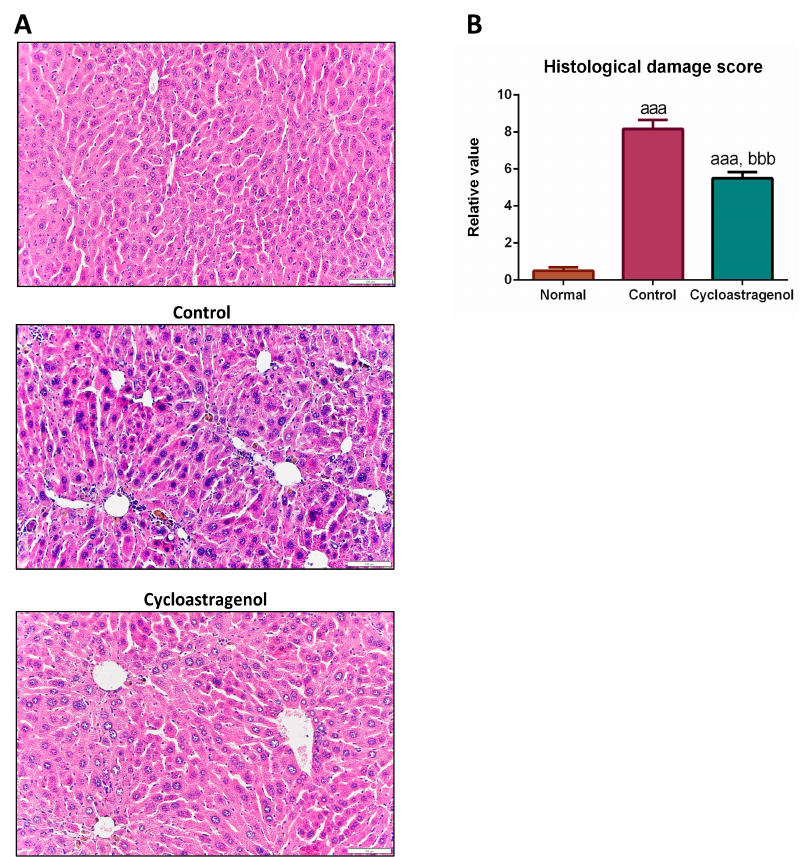
Figure 4. Hepatoprotective efficacy of cycloastragenol on histological damages in the liver of mice treated with carbon-tetrachloride. Representative hematoxylin/eosin-stained pictures of the liver among each group ( A ). The degree of hepatocyte degenerations, necrobiotic changes, and infiltrated lymphocytes were semi-quantified as histological damage scores. Data are shown when compared with the normal ( B ). Scaled bar = 100 µ m. Bar graphs and corresponding error bars indicate means and SEM among the same treatment, respectively ( n = 8–10). aaa and bbb indicate p < 0.001 when compared with the normal and control, respectively.